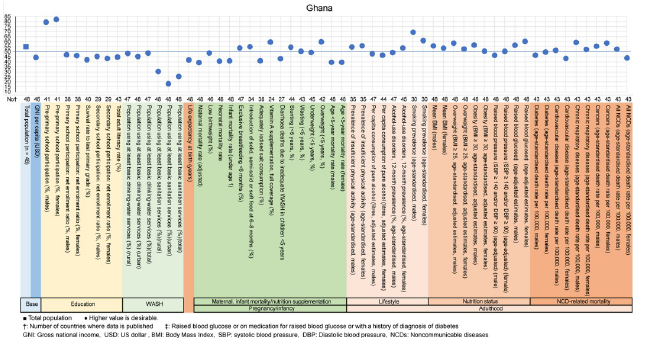
Fig 2. Country diagnosis by the deviation graph for